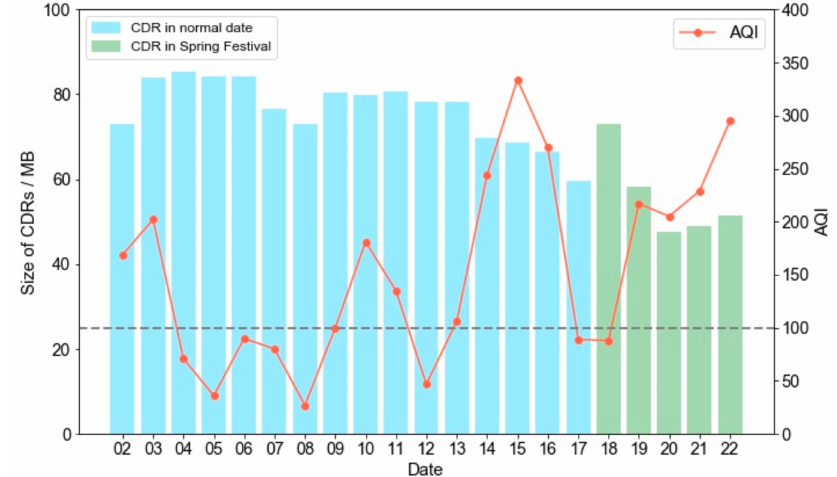
Figure 1. Daily CDR files’ sizes and AQI over the study period (N.B. the left y-axis represents the data size in megabytes, the x-axis date represents a day in the month in February 2015. The dotted line is a threshold AQI of 100 and represents a poor AQ in which it’s recommended that sensitive citizen groups should cut back or reschedule strenuous outdoor